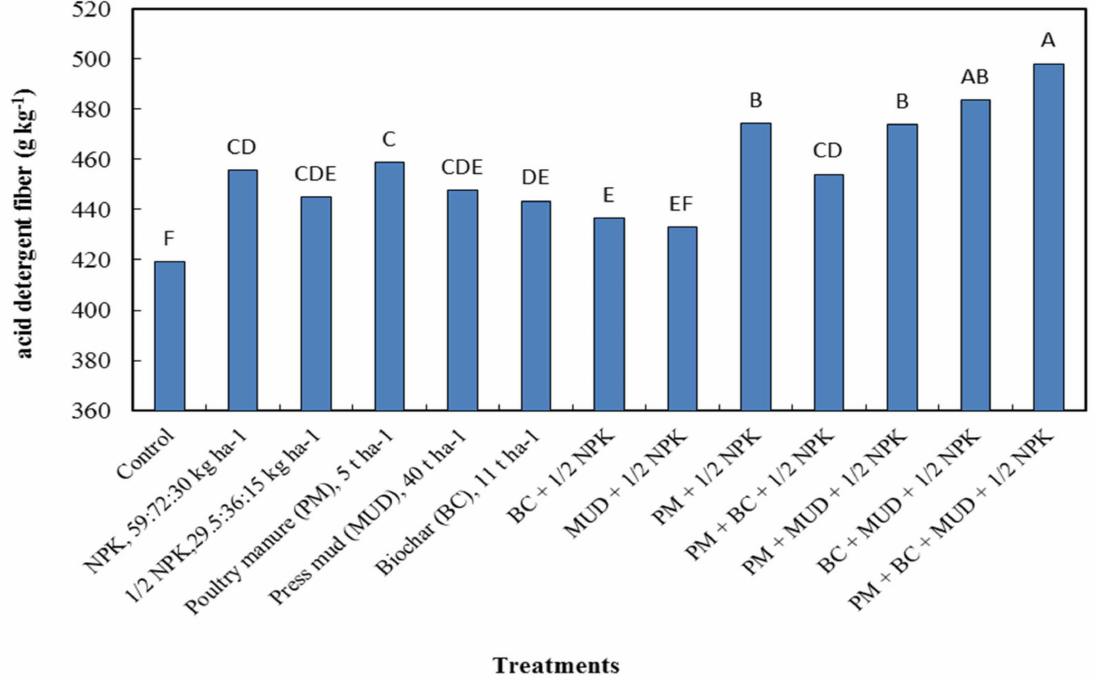
Figure 3. Effect of organic and inorganic amendments on acid detergent fiber of forage sorghum under the field conditions of Layyah, Pakistan. Values are the means of two years and three replicates. Means with similar letters at the top of the bar did not differ significantly at p ≤ 0.05 (HSD =